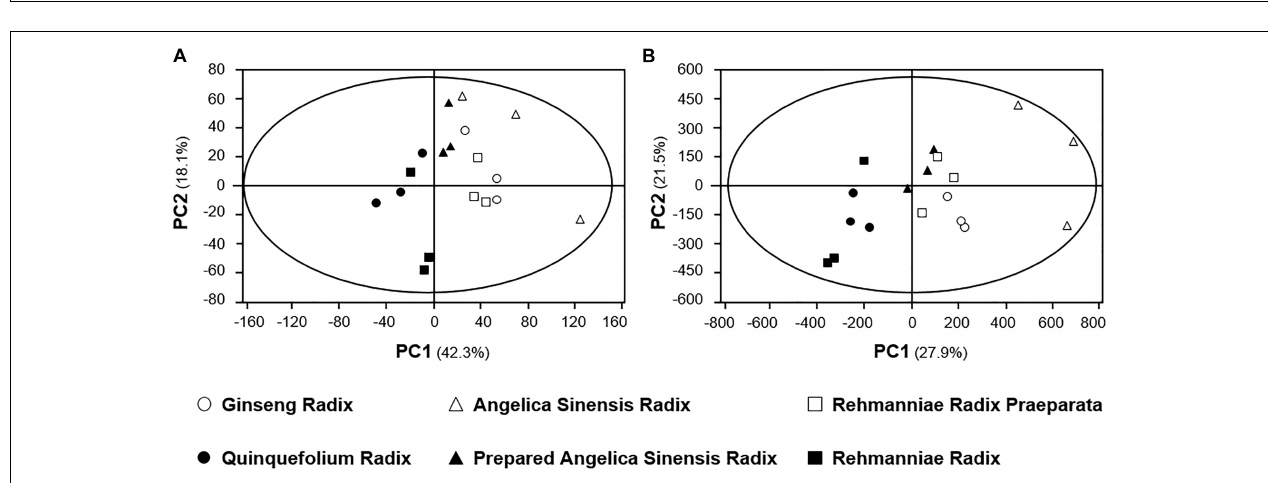
FIGURE 9 | PCA analyses of (A) TIC and (B) spectrum profiles of three paired-herbs with typical cold or hot property, i.e., Ginseng Radix-Quinquefolium Radix, Angelica Sinensis Radix-Prepared Angelica Sinensis Radix, Rehmanniae Radix Praeparata-Dried Rehmanniae Radix. The distribution of each herbal extract in score scatter plots was calculated according to its correlation with the major